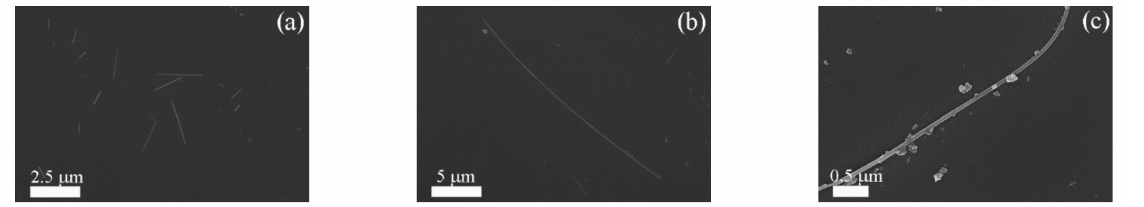
Figure 1. SEM images of TiO 2 ( a , b ) and g-C 3 N 4 /TiO 2 composite ( c